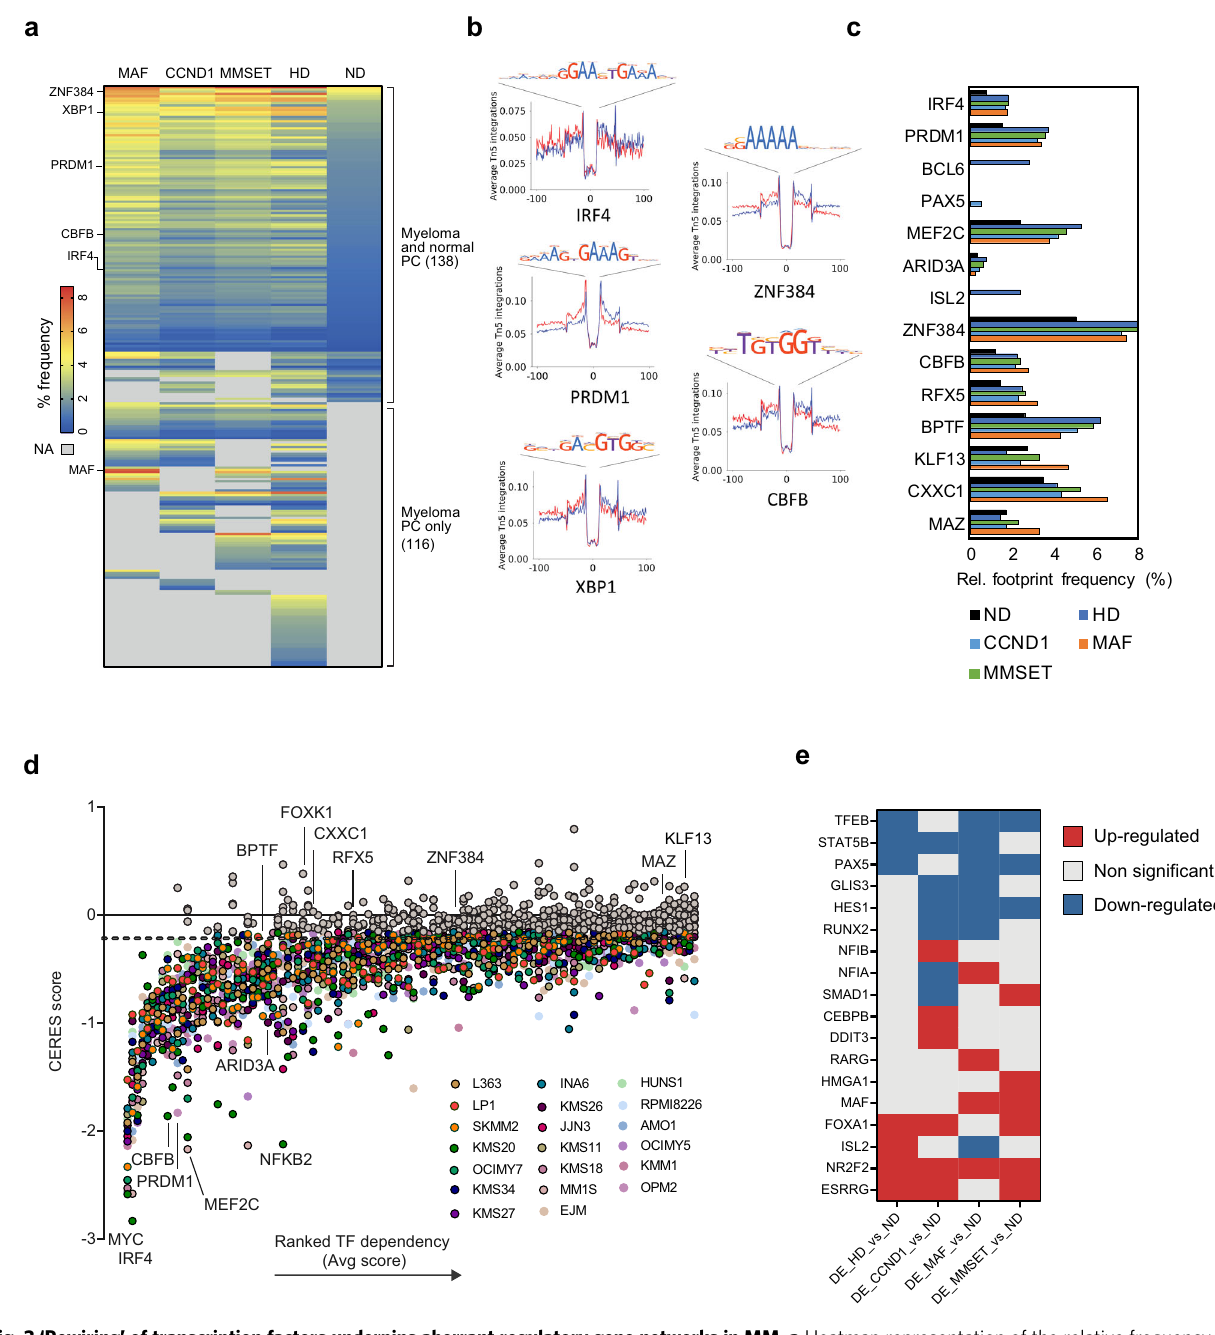
Fig. 3 ‘ Rewiring ’ of transcription factors underpins aberrant regulatory gene networks in MM. a Heatmap representation of the relative frequency of TF footprints across different MM genetic subgroups. TF are clustered based on their presence in both normal donor and myeloma PC (top) or in myeloma PC only (bottom). Grey values indicate lack of TF expression and/or predicted binding. b Footprints of indicated TFs identi fi ed in HD myeloma PC as determined by ATAC-seq. c Difference in relative footprint frequency of active TFs between different myeloma subgroups and normal donor PC. d TF dependency analysis using high-throughput CRISPR screens data from DepMap database (20 myeloma cell lines representing CCND1, MAF and MMSET genetic subgroups; colour-coded). Of the 247 TF shown, 137 are predicted to generate dependency, the top 100 of which are shown here. Examples of established and novel (bold) dependencies are indicated. In this analysis, dependency is de fi ned as CERES score < − 0.2 (horizontal dotted line) in at least 4/20 myeloma cell lines. e) TF that are differentially expressed between ND PC and myeloma genetic subgroup